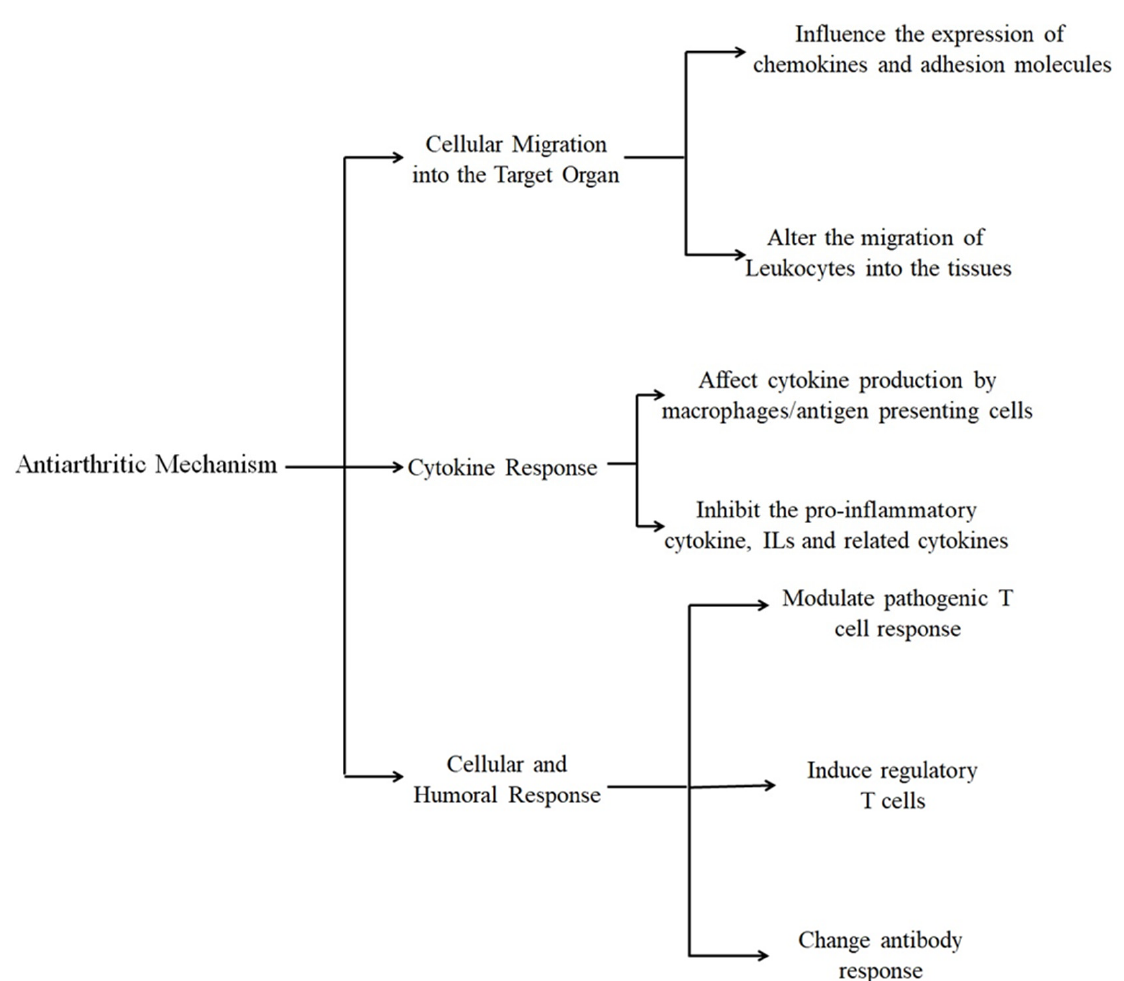
Figure 2. Mechanisms involved in the treatment of arthritis.